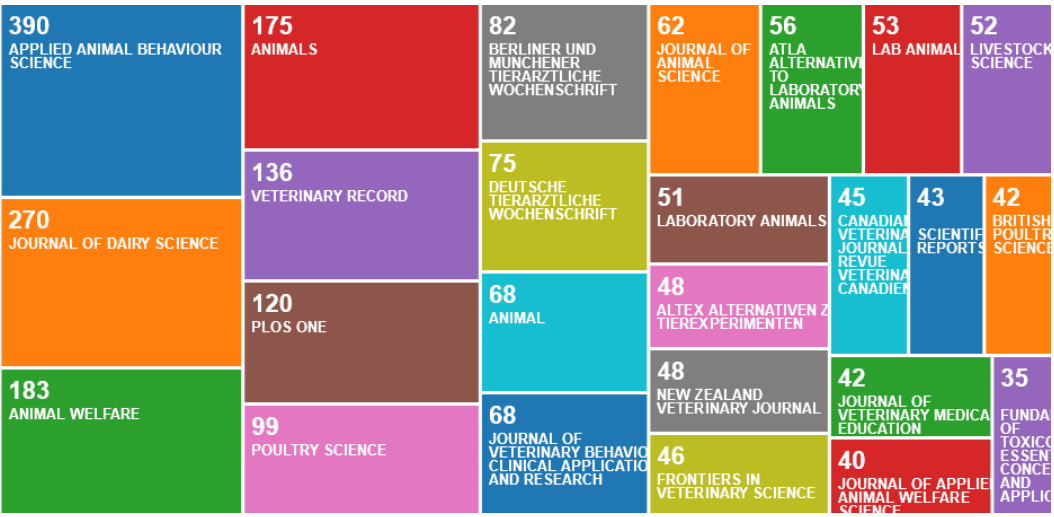
Figure 5. Number of publications per publication channel, according to an online survey of publications by animal welfare centres in the Web of Science, May 2020.